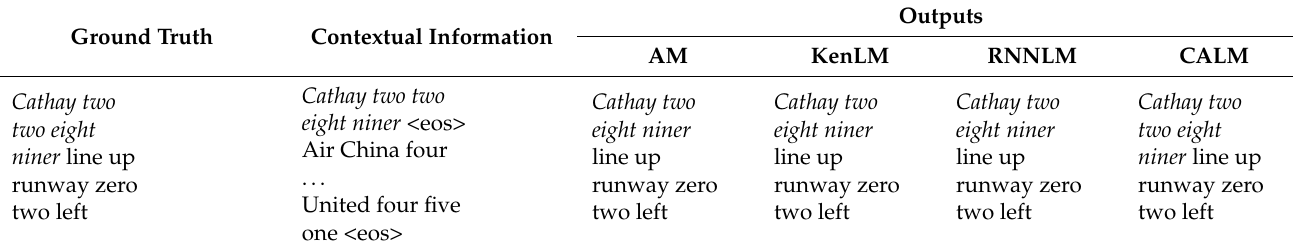
Table 5. Comparing results output by the baselines and the proposed